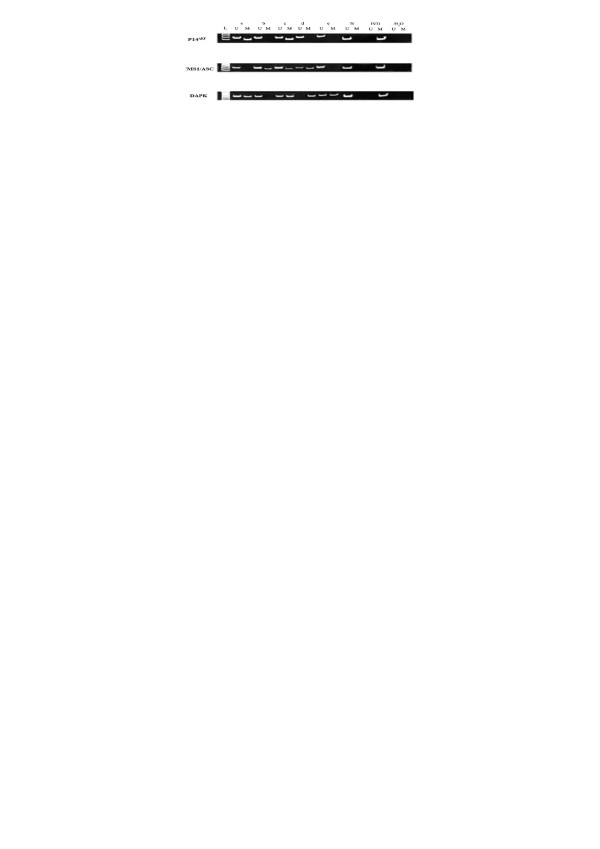
Methylation specific PCR analysis of p14ARF, TMS1/ASC, and DAPK in cholangiocarcinoma and normal adjacent tissue. L: 100 bp DNA ladder; U: unmethylated primers; M: methylated primers;. a-e:cholangiocarcinoma samples; IVD: positive control; N: negative control.